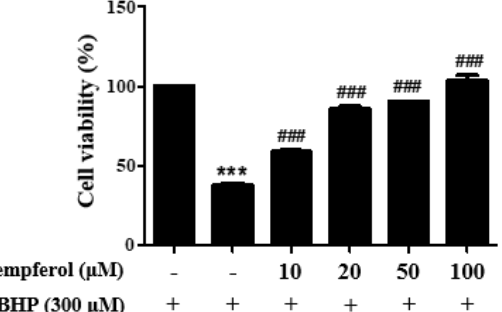
Figure 2. Effect of Kaempferol on the t -BHP-Induced HepG2 Cell Damage. HepG2 cells were pretreated with the indicated concentrations of kaempferol for 4 h and exposure to t -BHP (300 µ M) for 3 h. Cell viability was estimated using the 3-(4,5-dimethylthiazol-2-yl)-2,5-diphenyltetrazolium bromide (MTT) assay. Values are mean ± standard error ( n = 3). *** p < 0.001 vs. the control group and ### p < 0.001 vs. the t -BHP treated cells. Table 3. Effects of kaempferol on the body and liver weights of rats treated with CCl 4 . Compound Bodyweight (g)